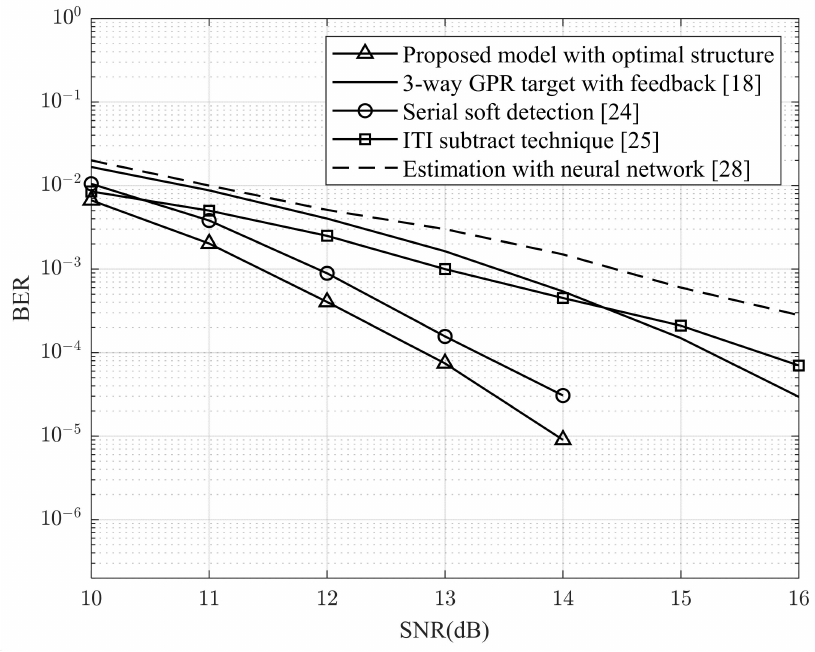
Figure 4. BER performance of proposed model